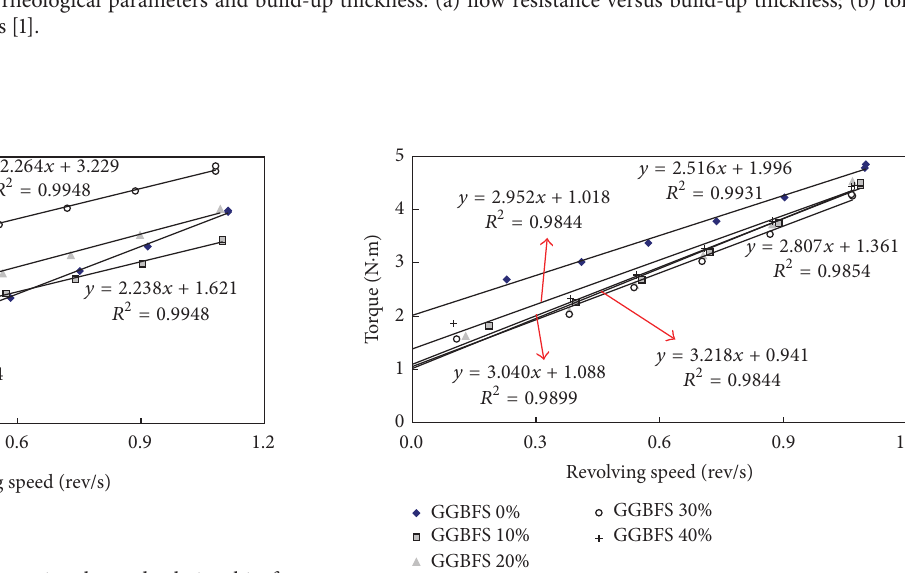
Figure 7: Exerted torque versus rotational speed relationship for GGBFS mixtures with 9.1% silica fume.